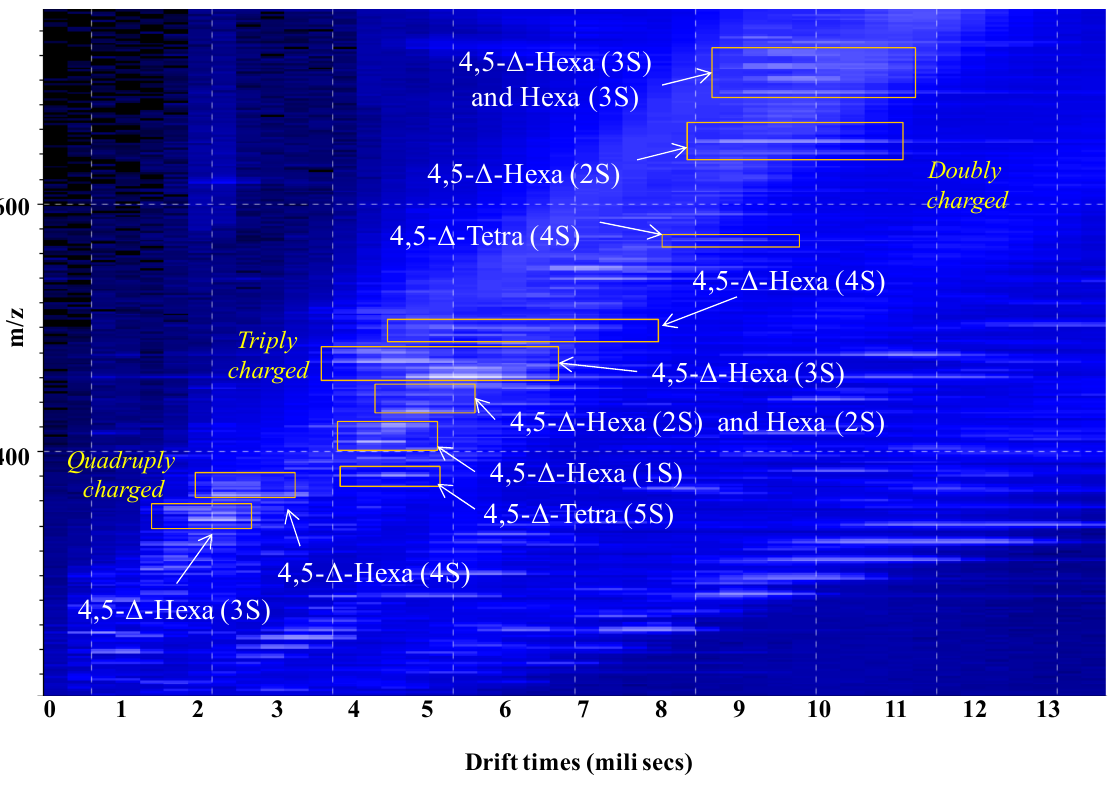
Figure 2. Driftscope display (drift time vs. m/z ) of the total distribution of CS/DS hexasaccharide fraction ions. In the drift cell, the ions were separated based on the charge state and the number of sulfate groups. n S-number of SO 3 groups.